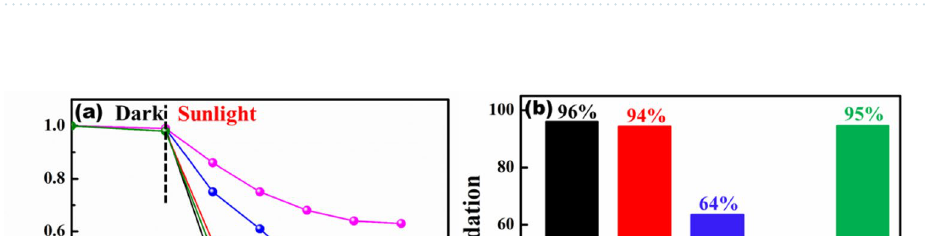
Figure 6. ( a ) Photocatalytic performance of activity of CFO, g-C 3 N 4 , CCN10, CCN25, CCN50 and CCN75 to degrade MB ( b ) corresponding reaction kinetics, and photodegradation profile of MB using ( c ) CFO ( d ) CCN50. (reaction conditions: pH = 7.2, temperature = 32 °C).